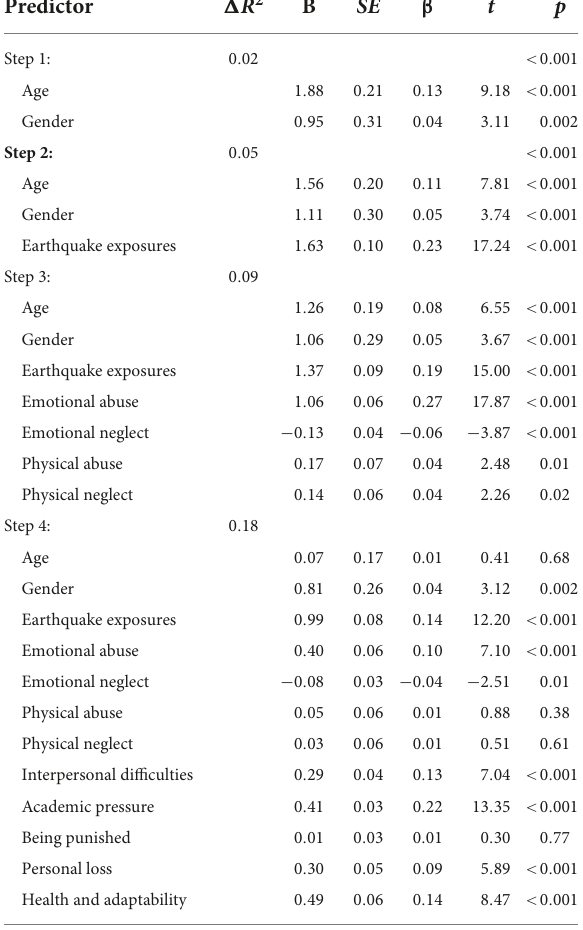
TABLE 4 Hierarchical multiple regression analysis to identify the factors associated with PTSD in adolescents experiencing multiple difficulties (N = 5,195) a